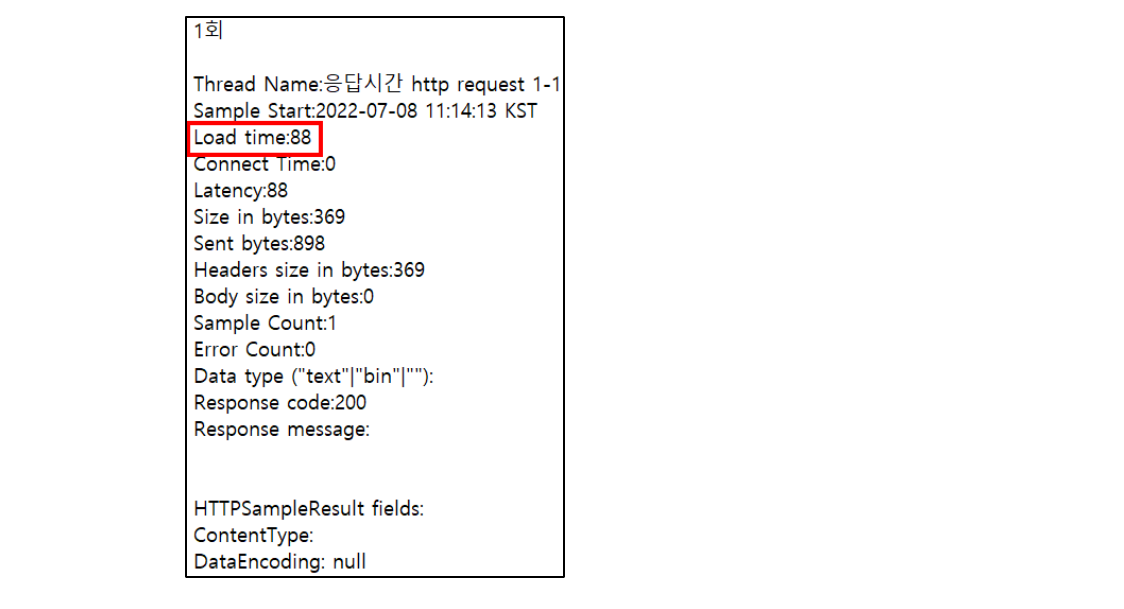
Figure 15. Apache jMeter execution log example. (For your information, In this figure, the non- English term “ 응답시간 ” means “response time” in English) .